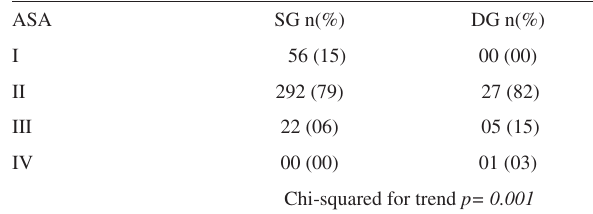
Table 3 – Cohort patients: comorbidities, according to the